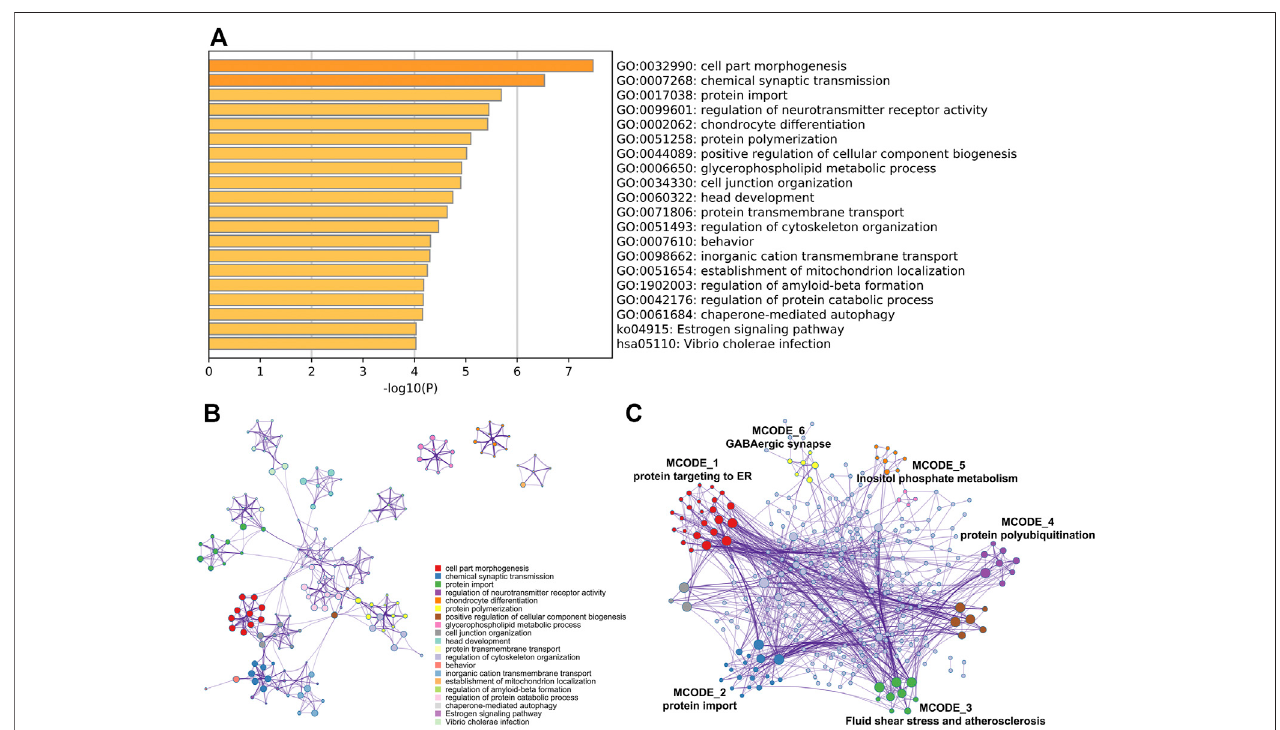
FIGURE2 | Gene functional enrichment analysis. GO annotationand KEGG pathway enrichmentanalysisof the aberrantly methylated and differentially expressed genes was analyzed by Metascape (A) Bar graph of the top 20 enriched terms across, colored by p -values (B) Network of the top 20 enriched terms and (C) MCODE components was identi fi ed from the PPI network.